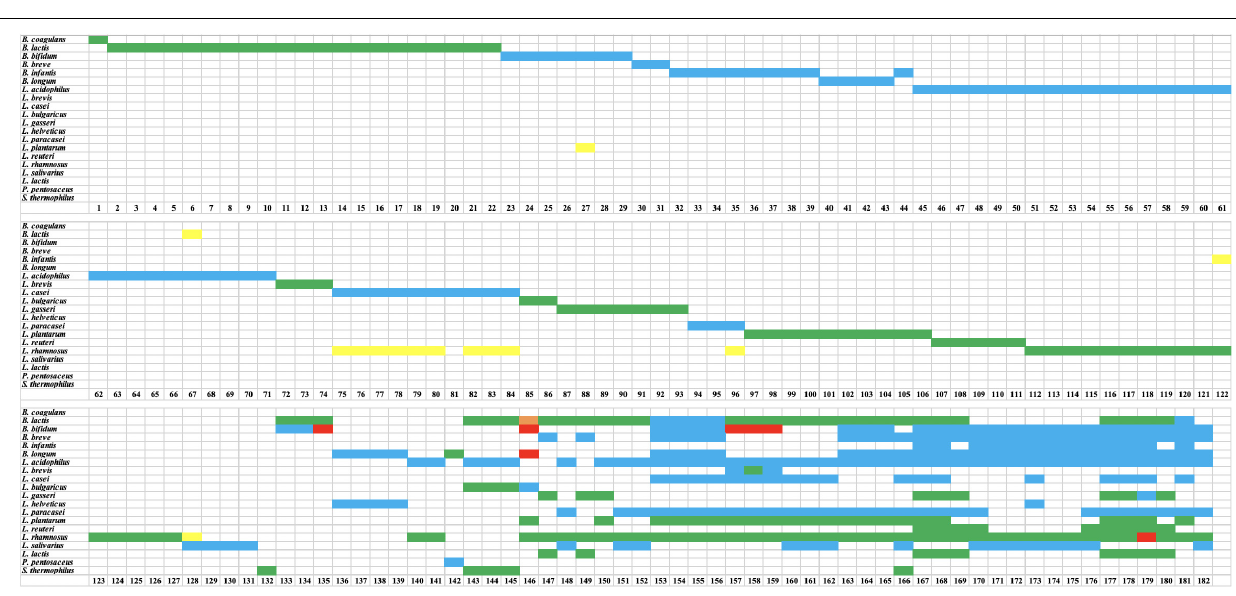
FIGURE 3 | Results of high throughput sequencing (HTS) of probiotic samples. Green indicates that a declared species was present. Blue indicates that a declared species was identified to genus level only. Red indicates a species was declared but absent. Orange indicates that a species was not declared but was present. Yellow indicates that a species was not declared but was present at low relative abundance ( ∼